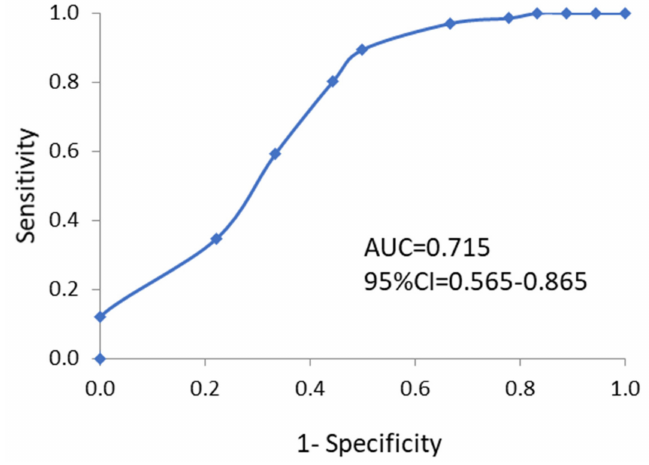
Figure 3. Receiver operating characteristics (ROC) curves for FMS scores and injury risk. The area under the curve (AUC) with 95% confidence interval (CI) was